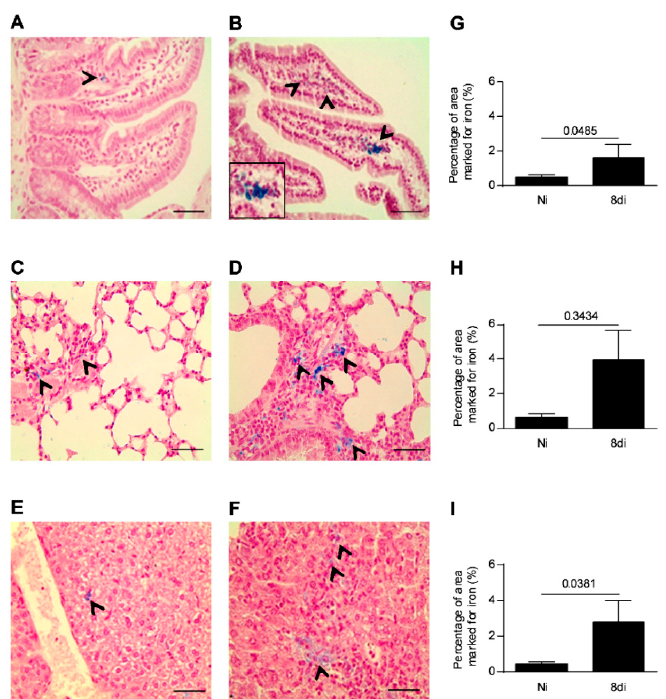
Figure 1. Iron positive areas in the small intestine, lung, and liver of T. gondii -infected mice. Representative photomicrographs of iron positive areas detected by Perls staining in the small intestine ( A , B ), lungs ( C , D ), and liver ( E , F ) of C57BL / 6 female mice infected with 20 cysts of ME-49 T. gondii strain or non-infected mice examined on day 8 of infection. The areas with cells iron stained (blue) were captured per tissue sections by light microscopy using 40× objective and quantified using ImageJ software ( G – I ). Non-infected (Ni); days of infection (di). The black arrows indicate areas with iron positive cells. Mann–Whitney test. Scale bar = 50 µ m.